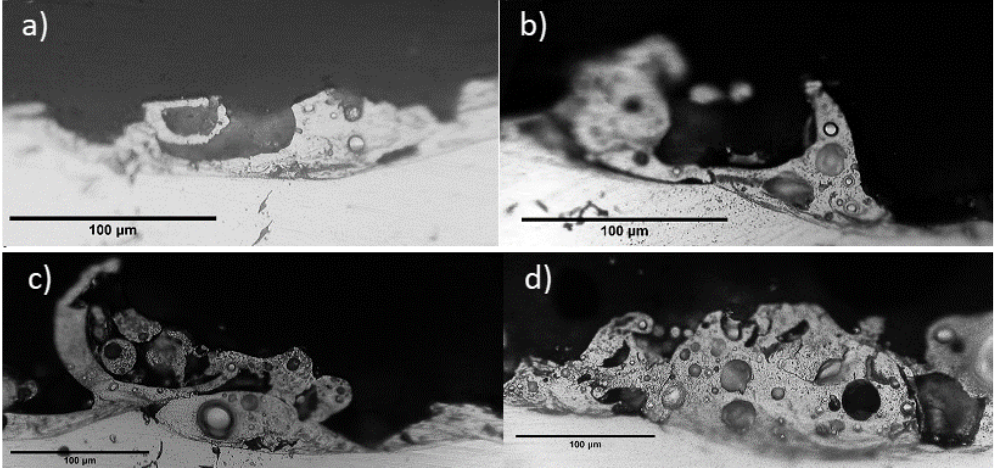
Figure 5. Details from the WL for I P = 18 A and T on ( a ) 100 μs. ( b ) 200 μs. ( c ) 300 μs. ( d ) 500 μs.